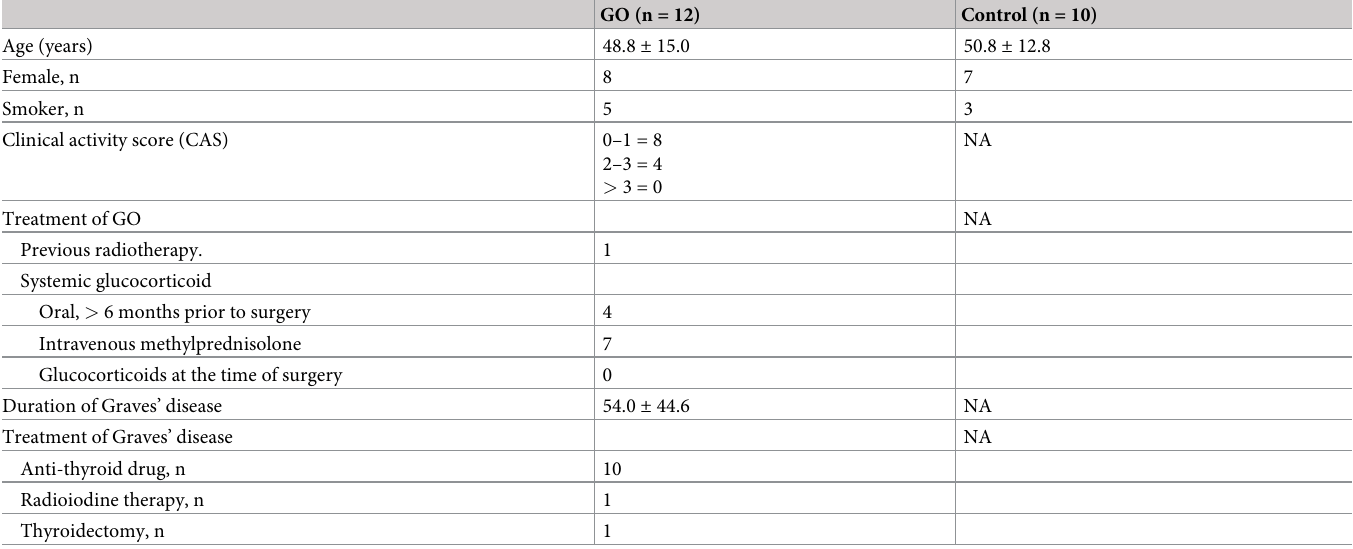
Table 1. Demographic and clinical data in Graves’ orbitopathy (GO) and control